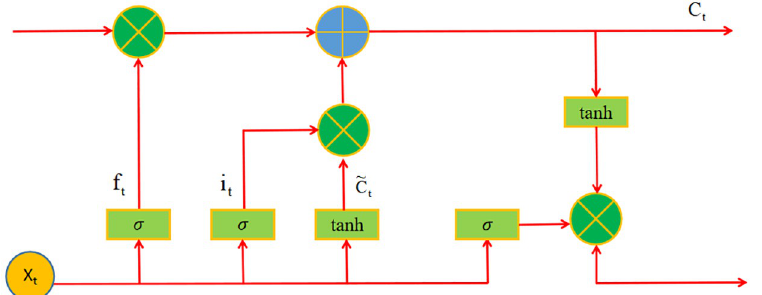
Fig 1. Plot of the LSTM unit